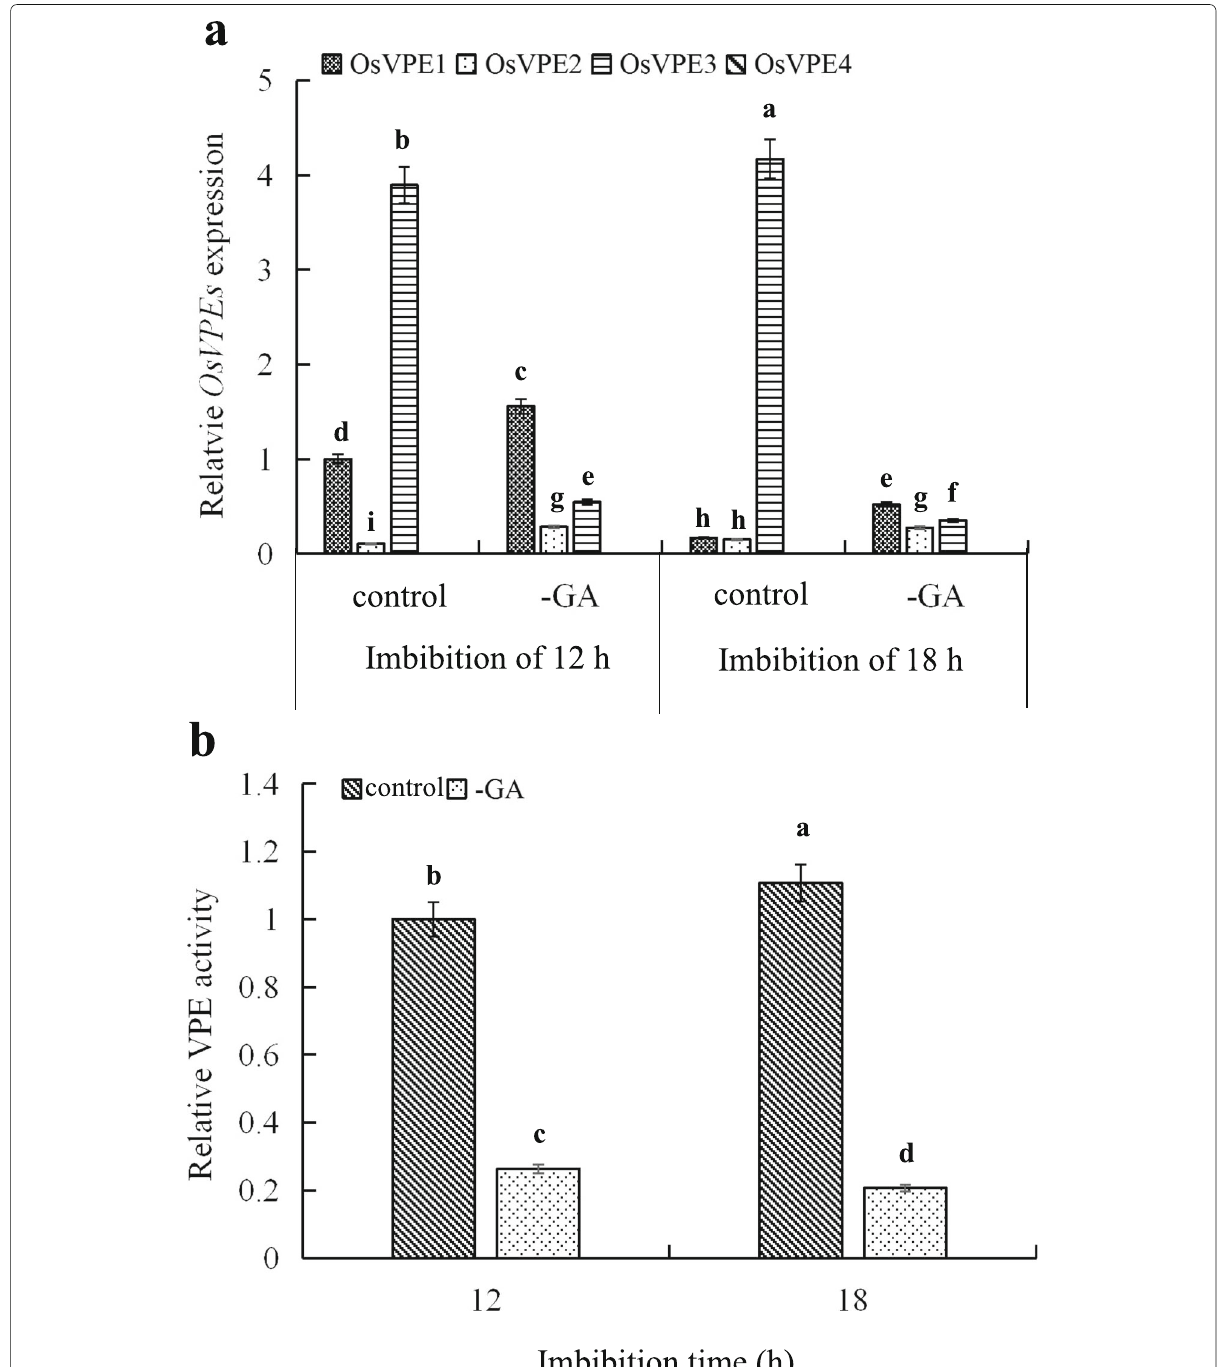
Fig. 2 GA raised the levels of OsVPE3 mRNA transcript expression and VPE activity. The relative levels of OsVPE1-4 expression ( a ) and VPE activity ( b ) in the aleurone layers obtained from intact seeds (control) and de-embryo seeds (GA) after 12 h and 18 h of imbibition. The OsVPE1 expression ( a ) and VPE activity ( b ) in the aleurone layers isolated from the intact seeds imbibed for 12 h were selected as 1. Error bars represent the means ± s.d., n = 3 biological independent experiments with at least three replicates for each. Bars with different alphabets show significant different at P < 0.05 by Duncan’s multiple range